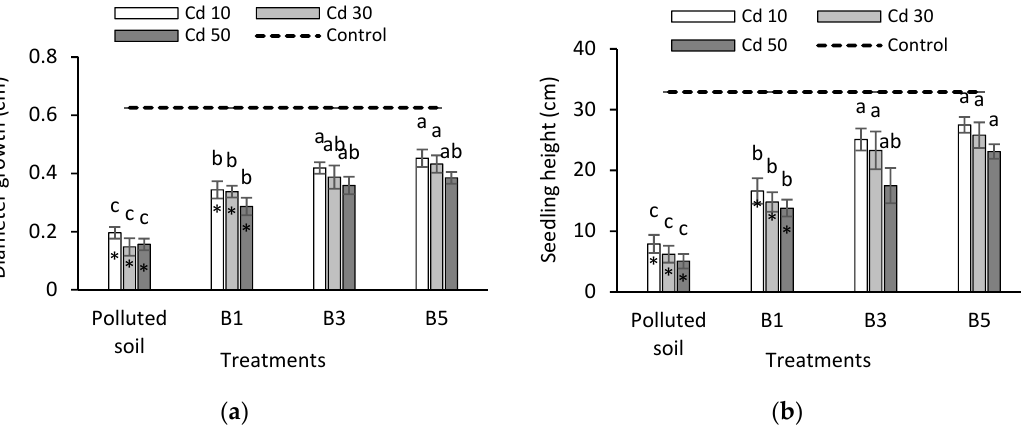
Figure 2. Effect of different levels of biochar on diameter growth and seedling height in oak seedlings at different levels of Cd contamination (means + / - standard deviation): diameter growth ( a ) and seedling height ( b ). The dashed line represents the control (no biochar, no Cd), and the term “Polluted soil” indicates pots with Cd but without biochar. Different letters represent significant differences between treatments. The star indicates a significant difference between treatments and control.